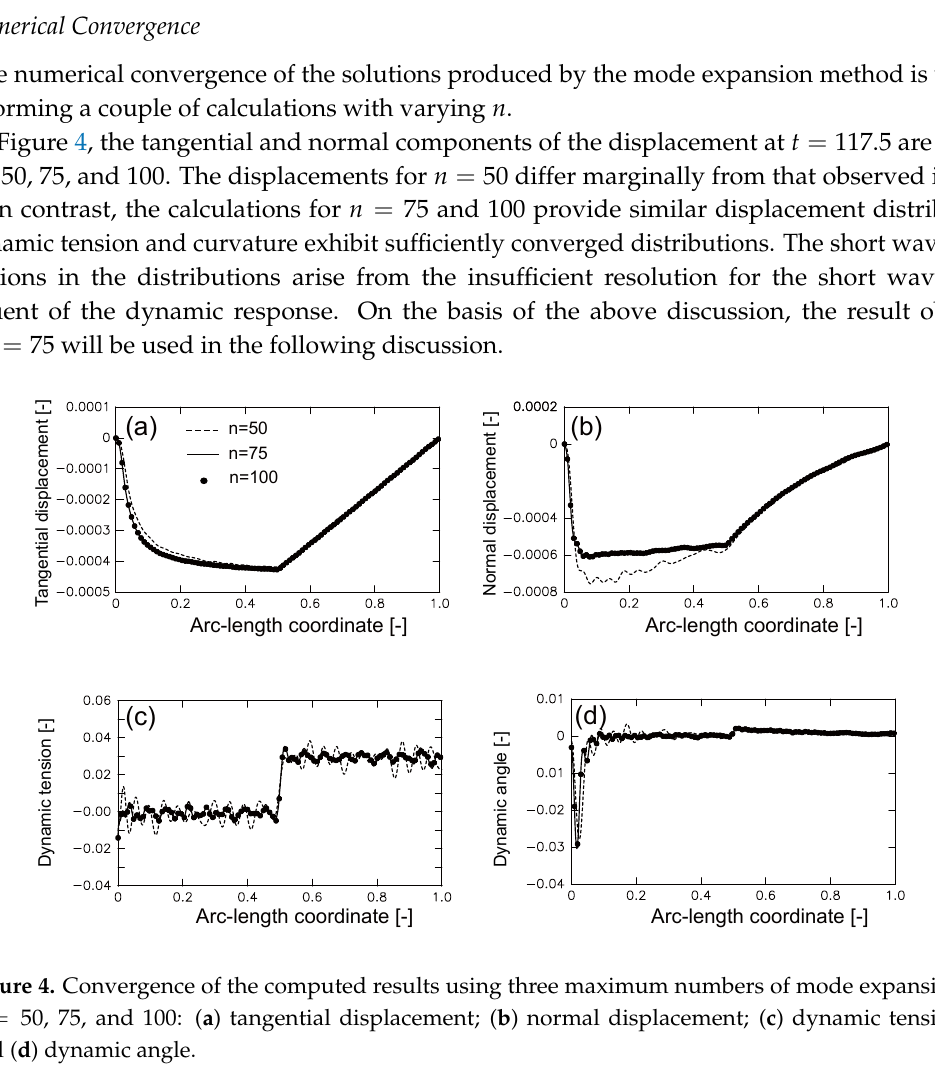
Figure 3. Comparison of the computed results using analytical and numerical integrations for a straight cable: ( a ) tangential displacements; and ( b ) normal displacements at t = 117.5.